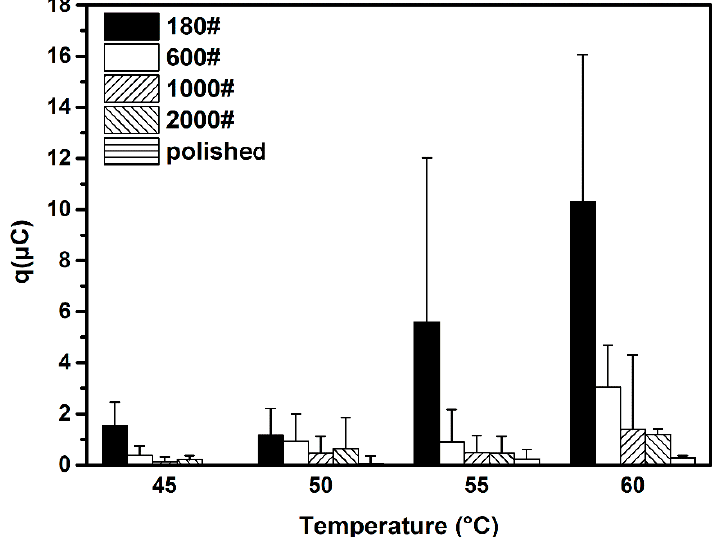
Figure 15. Average charge quantity of ECN transient of different surface roughness DSS 2205 specimens at four test temperatures.